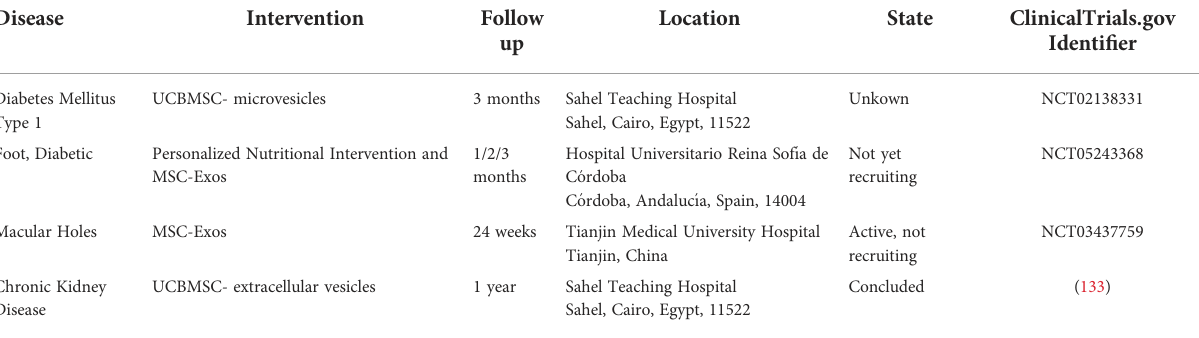
TABLE 3 Clinical trial of MSC-Exos in the treatment of diabetes and related complications.